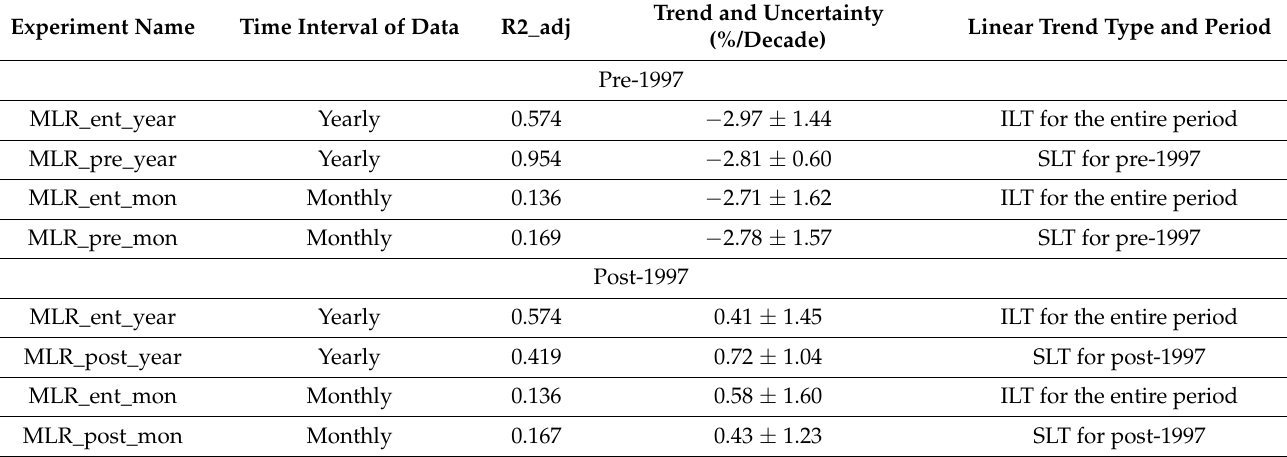
Table 2. Trends and 2-sigma uncertainties derived from the monthly and yearly MLR analysis for the zonal averaged SBUV total column ozone between 35–40 ◦